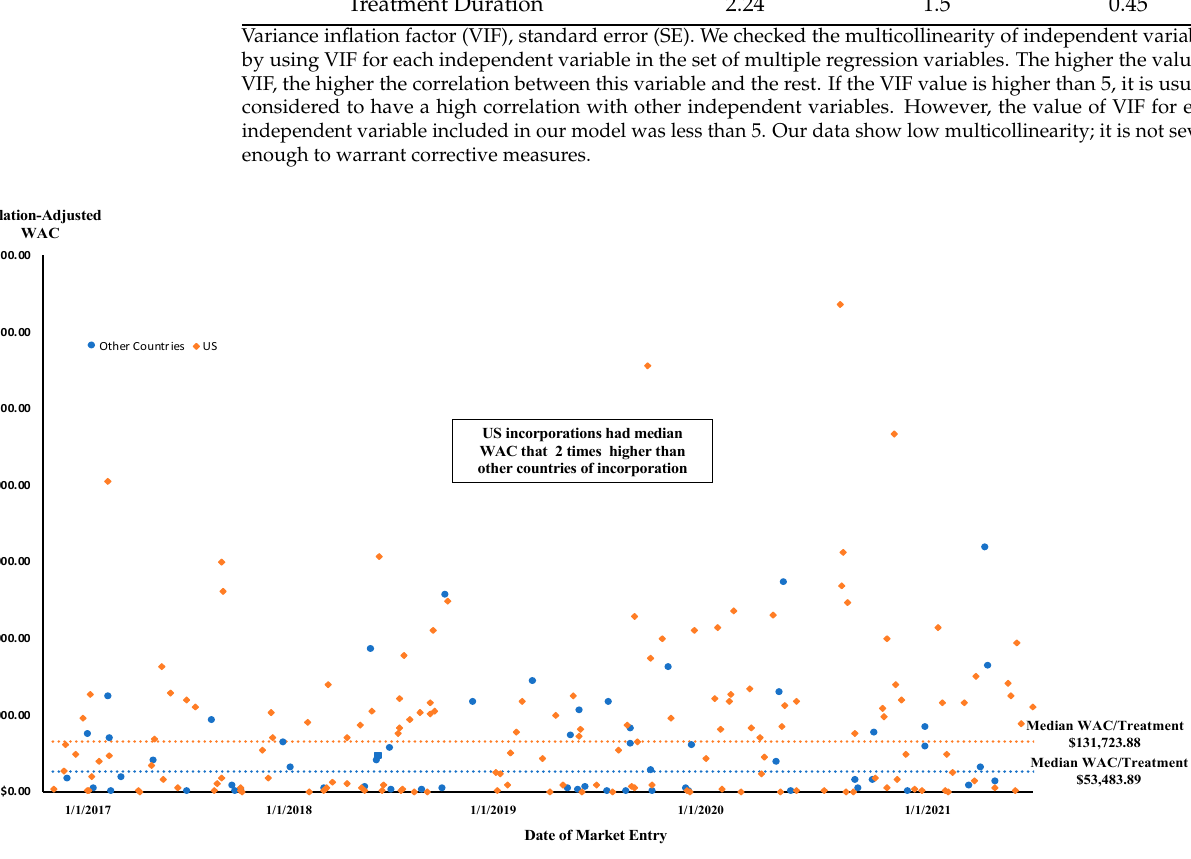
Figure A1. New drugs treatment cost at US market entry (USD 2021) and median WAC.